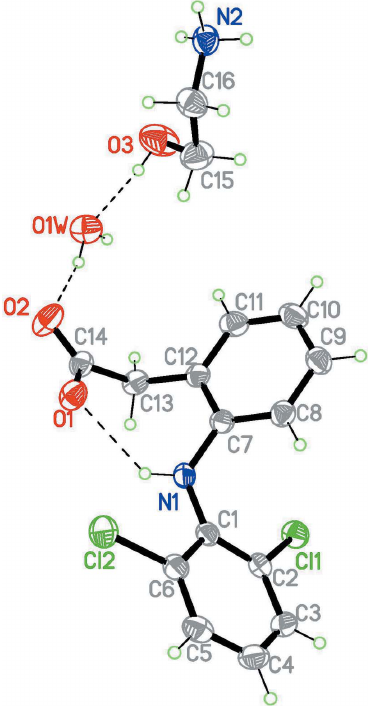
Figure 1 Perspective view of the title compound with the atom-numbering scheme. Displacement ellipsoids are drawn at 40% probability level. The dashed lines represent hydrogen bonds within the asymmetric Table 1], which forms a seven-membered ring with graph-set notation S (7) (Etter, 1990). The dihedral angle between the